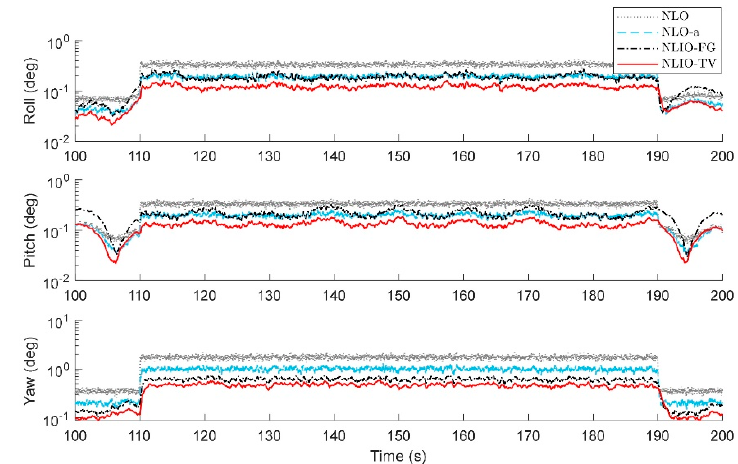
Figure 10. Averaged absolute attitude estimation error between 100 s and 200 s over 100 simulations for Case 3.